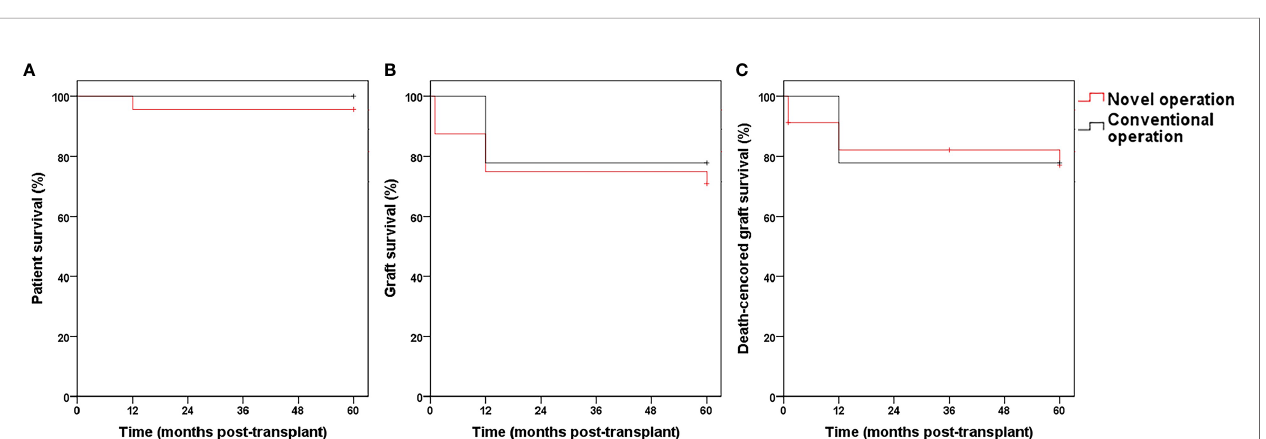
FIGURE 6 | The patient survival ( A , P > 0.05), graft survival ( B , P > 0.05) and death-censored graft survival ( C , P > 0.05) rates in Group novel operation and conventional.